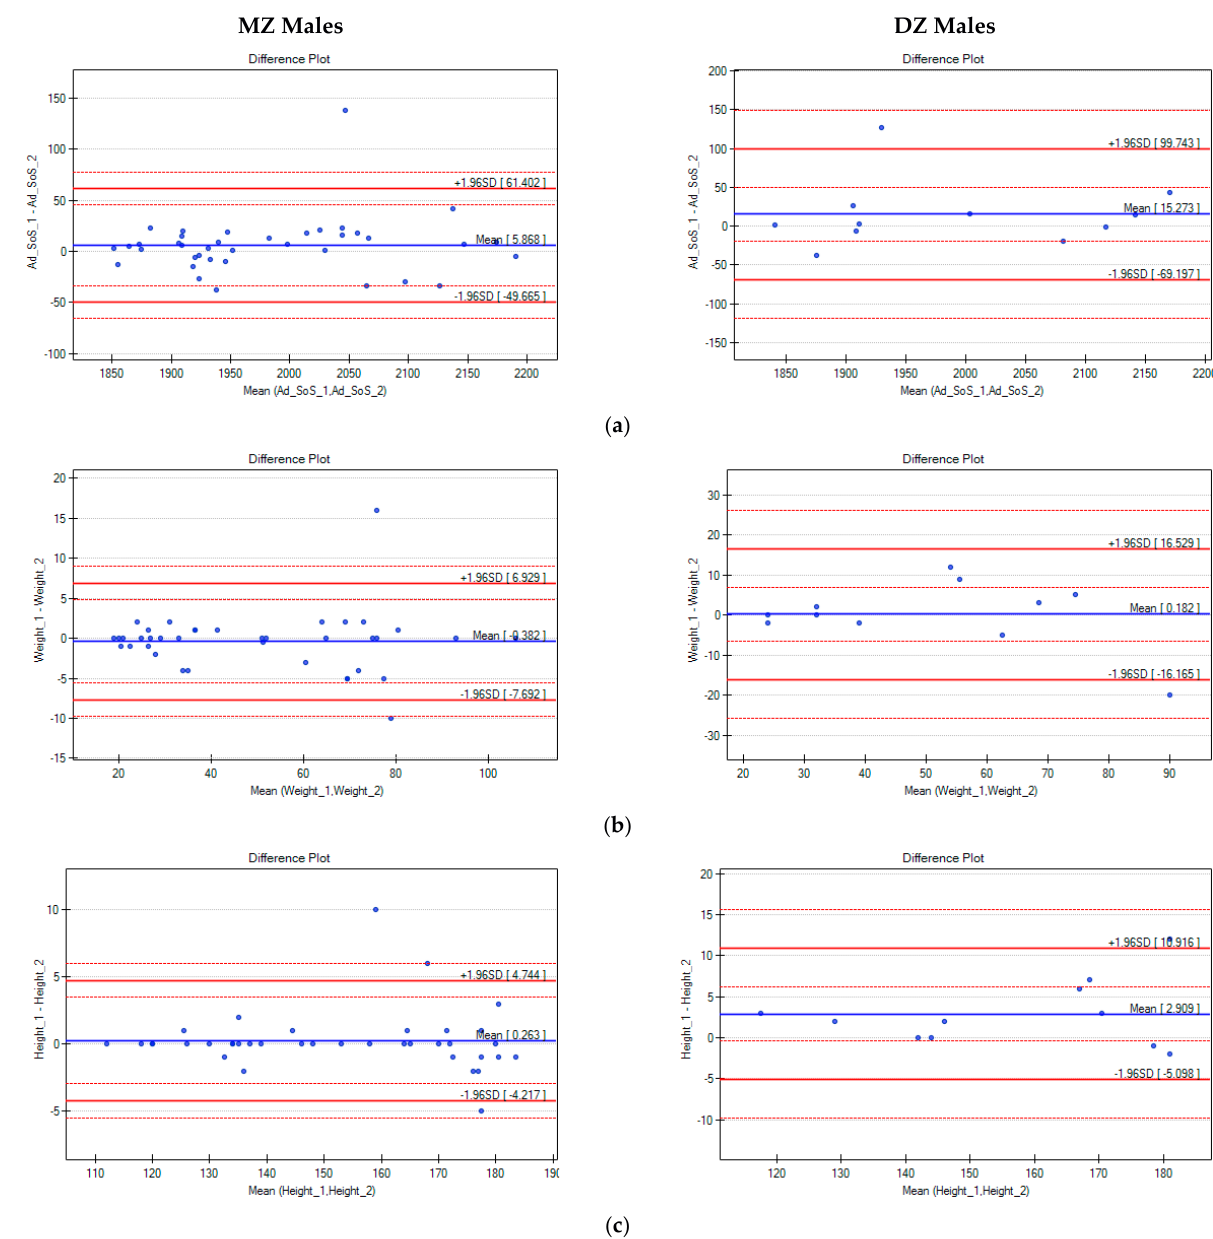
Figure 1. Bland–Altman plots for Ad-SoS ( a ), weight ( b ), and height ( c ) differences in pairs of male twins (the x-axis represents the mean values of the parameters in twin pairs, and the y-axis represents the intrapair differences between twin A and twin B).